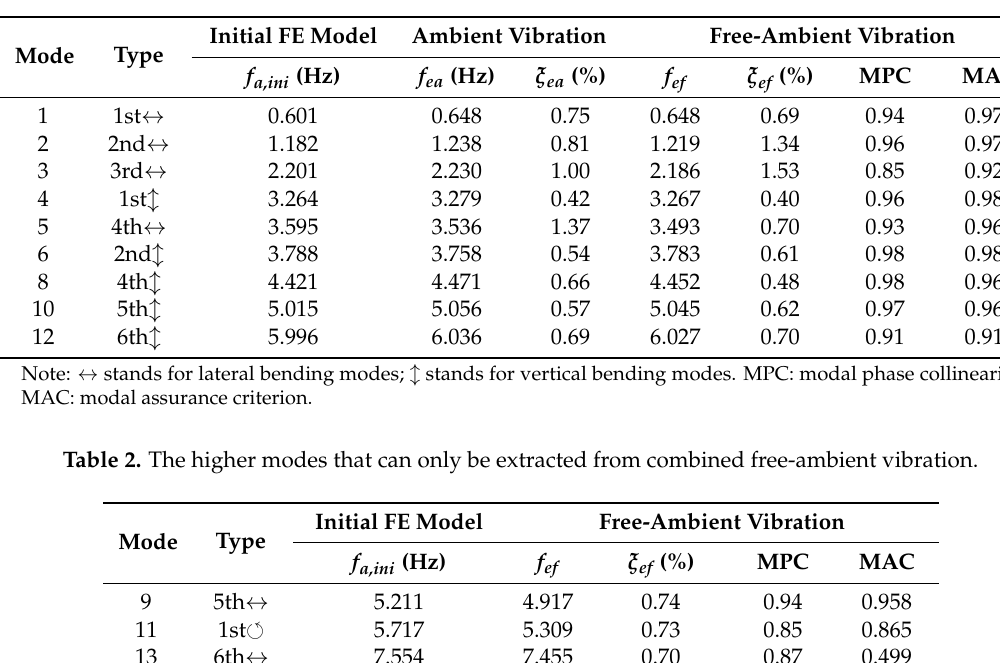
Table 1. The lower modes that can be extracted from both ambient and combined free-ambient vibration.